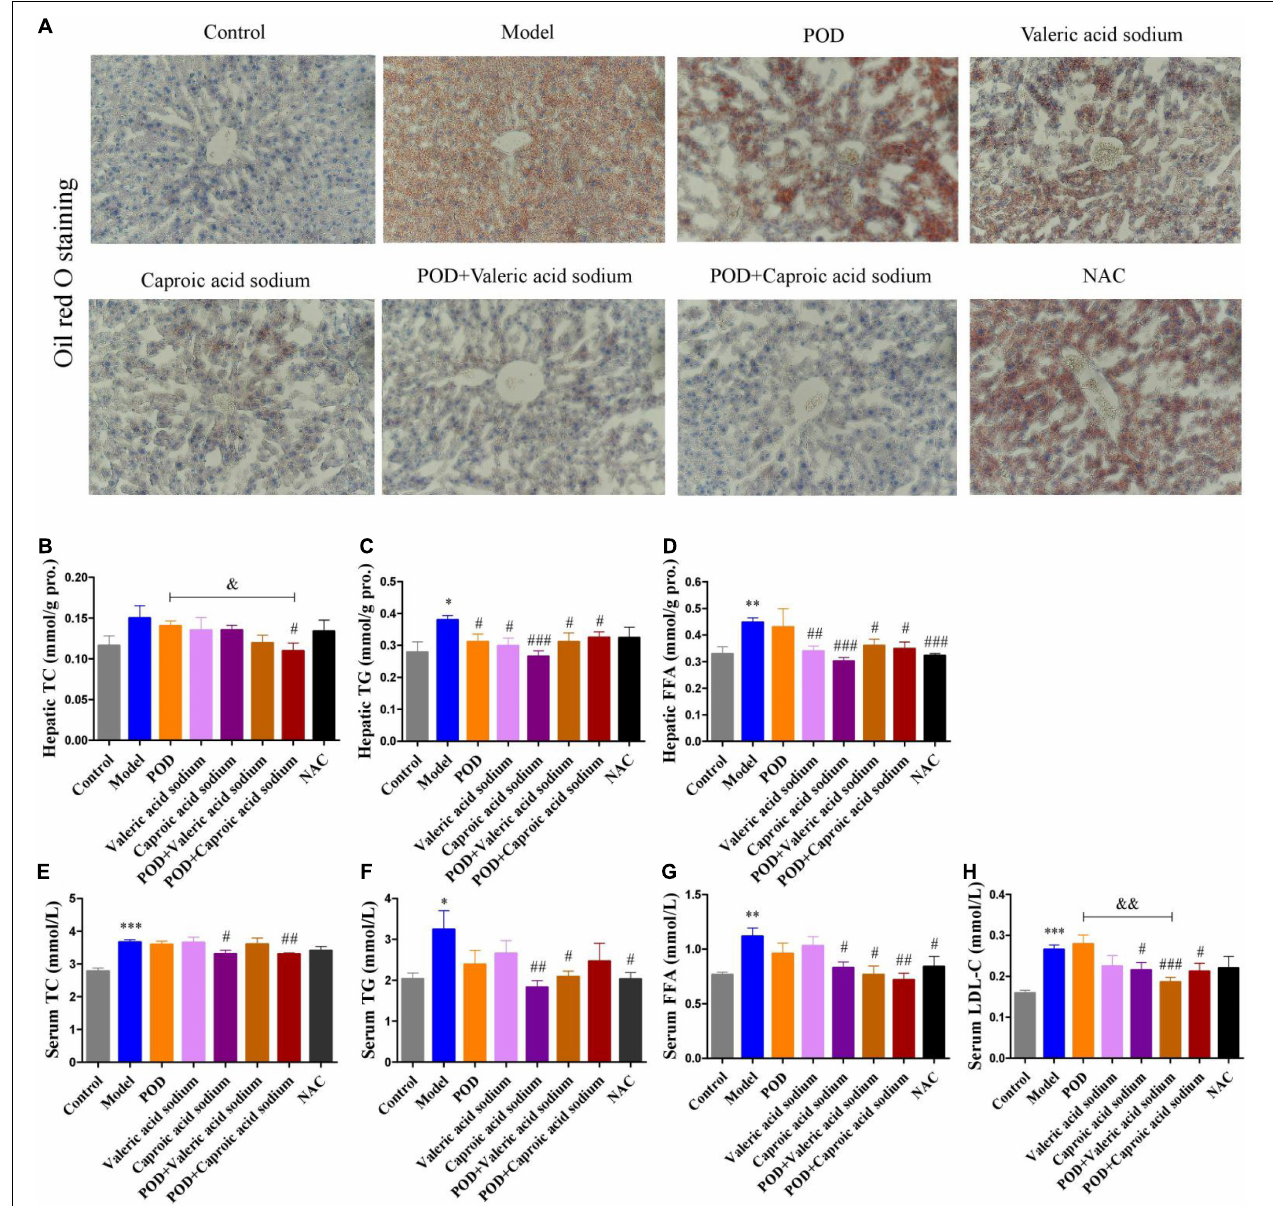
FIGURE 6 | Effects of valeric acid and caproic acid on lipid metabolism in mice fed a high-fructose diet. (A) Oil red O staining (200 × ). (B–D) Levels of TC, TG, and FFA in liver. (E–H) Levels of TC, TG, FFA, and LDL-C in serum. Data are presented as mean ± SEM. ∗ p < 0.05, ∗∗ p < 0.01, ∗∗∗ p < 0.001, compared to